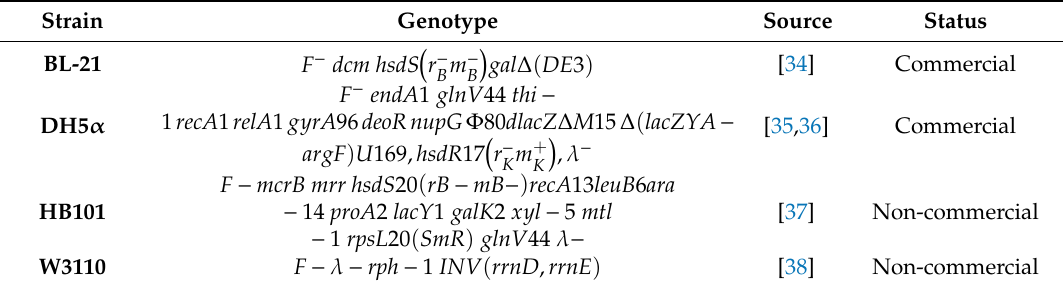
Table 1. Strains selected for the study and their